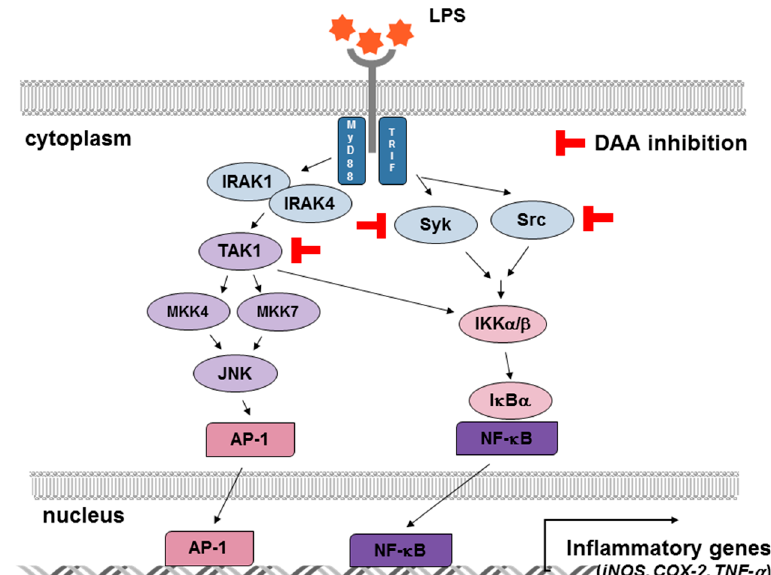
Figure 6. Inhibitory effects of DAA on inflammatory signaling pathways. DAA suppressed the activities of TAK1 in AP-1 cascades and of Syk and Src in NF- κ B cascades. These inhibitory actions conclusively reduced the production of inflammatory mediators such as iNOS, COX-2, and TNF- α . T bars are inhibitory action of DAA and black arrows indicate signal transduction.